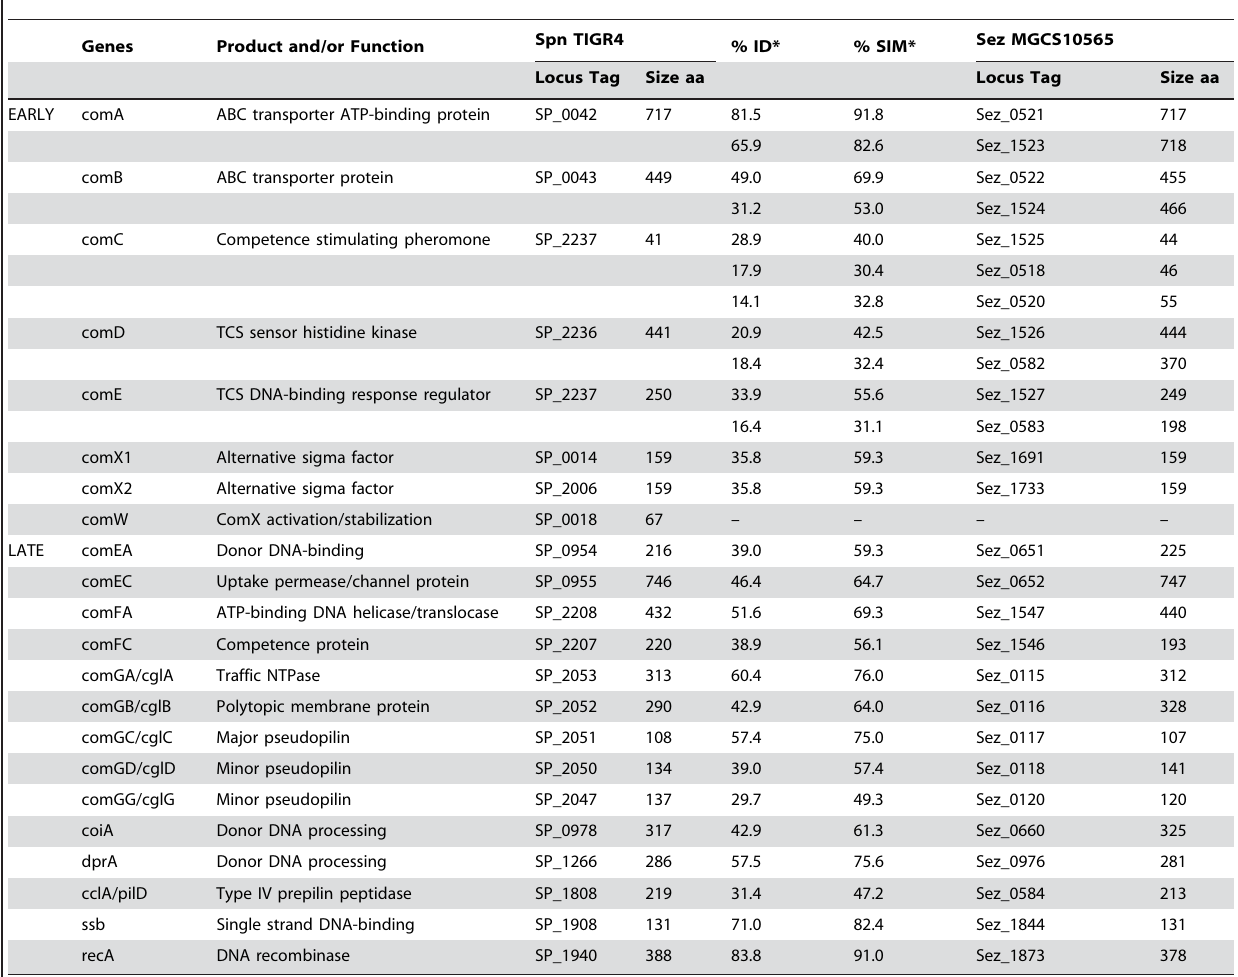
Table 2. Essential Competence